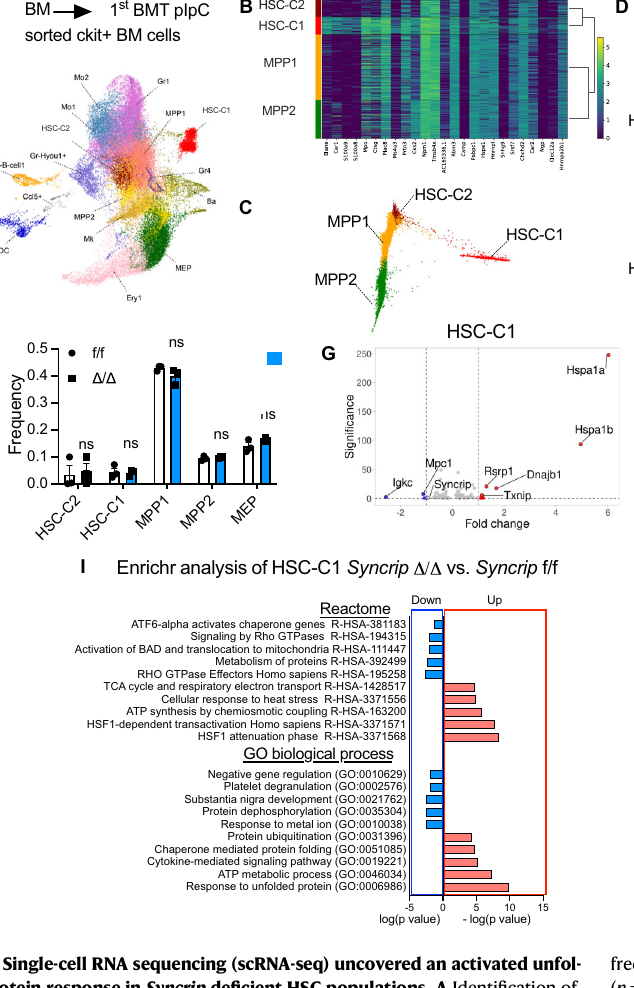
Fig. 3 | Single-cell RNA sequencing (scRNA-seq) uncovered an activated unfol- ded protein response in Syncrip de fi cient HSC populations. A Identi fi cation of hematopoieticcellpopulationswithinWT Syncrip f/f ( n =3)andKO Syncrip Δ / Δ ( n =3) Lin-ckit+ cells based on UMAP analysis of Single-cell RNA sequencing (scRNA-seq). B Gene expression heat map of the highly expressed genes in hematopoietic stem cell-cluster 1 (HSC-C1), hematopoietic stem cell-cluster 1 (HSC-C2), multipotent- progenitor 1 (MPP1) and 2 (MPP2) populations. C Reconstruction of the lineage branching among of four early hematopoietic stem/progenitor cells HSC-C1, HSC- C2,MPP1andMPP2populationsusingdiffusionpseudotime(DPT)analysis. D GSEA analysis of genes differentially expressed between HSC-C1 vs. HSC-C2 in WT Syn- crip f/f mice for enrichment of gene signatures speci fi c for low output and high output HSC. E UMAP displays of all hematopoietic clusters of WT Syncrip f/f and KO Syncrip Δ / Δ scRNA-seqasdescribedin( A ).ClusterHSC-C1showsthemostshift.HSC, Ba and MEP clusters were highlighted for comparison. F Quantitative summary of